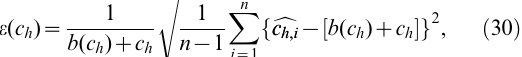
: : 0 : 88 and c J ¼ 0 : 15 . For the folded : : 0 : 91 and c J ¼ 1 : 15 . The